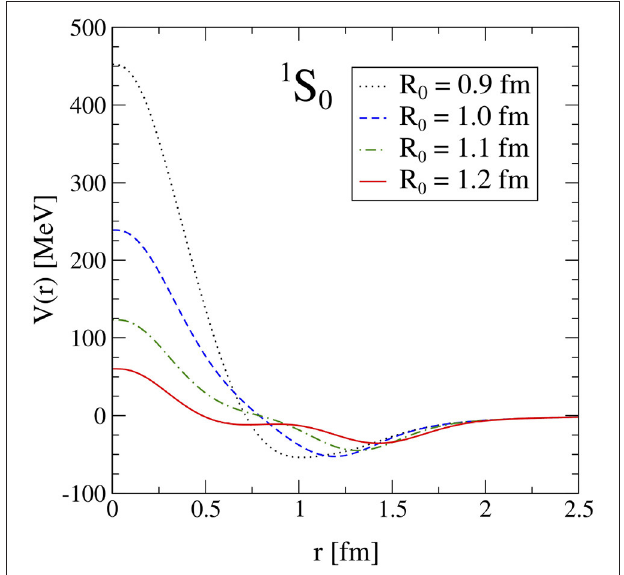
FIGURE 2 | Local delta-less chiral potential in the 1 S 0 partial wave at N 2 LO. The smaller the coordinate-space cutoff R 0 , the smaller is the short-range repulsive core. Figure taken from Gezerlis et al. [ 105] under the Creative Commons CCBY